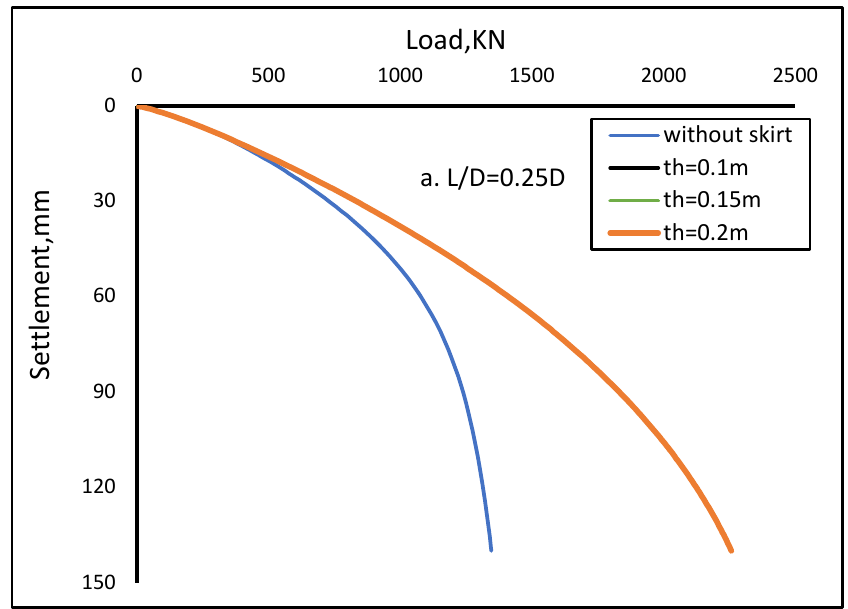
Fig. 3. Load-settlement relationship for skirt circular footing, L/D=0.